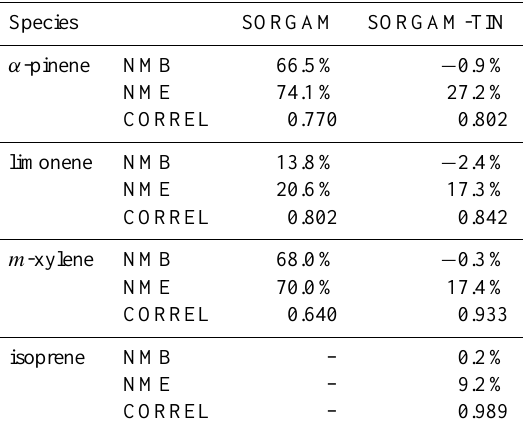
Table 4. Evaluation of box model simulations with SORGAM and SORGAM-TIN for all